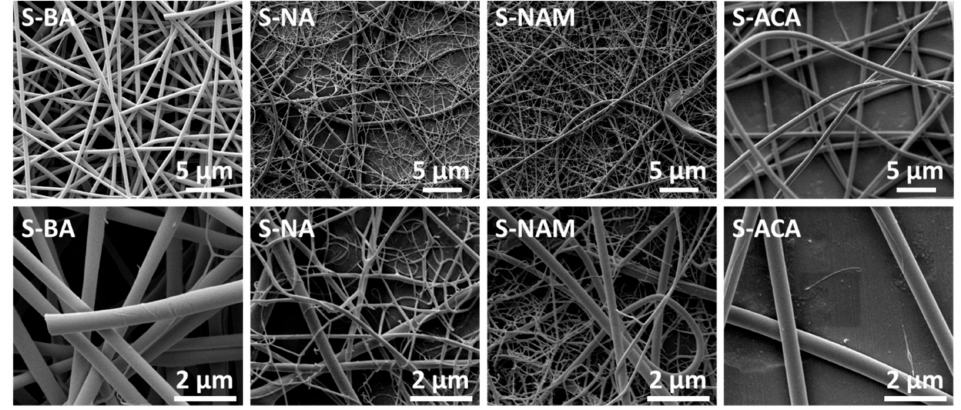
Figure 2. SEM images of the monolithic fibers (top: 10,000 × magnification; bottom 40,000 ×